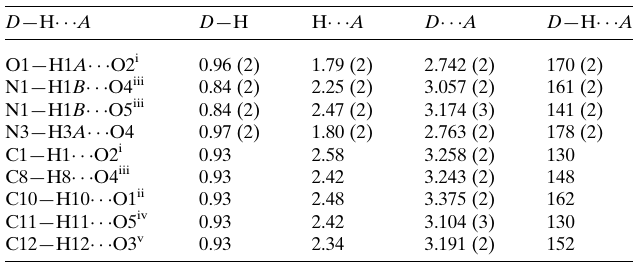
Table 1 Hydrogen-bond geometry (A˚ , (cid:4) ).